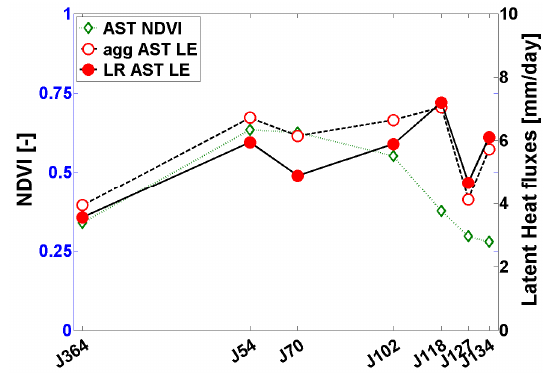
Figure 5. ‘ agg-ASTER’ (agg AST) and ‘LR-ASTER’ (LR AST) SEBS latent heat flux, along with ASTER NDVI (AST NDVI) time series.